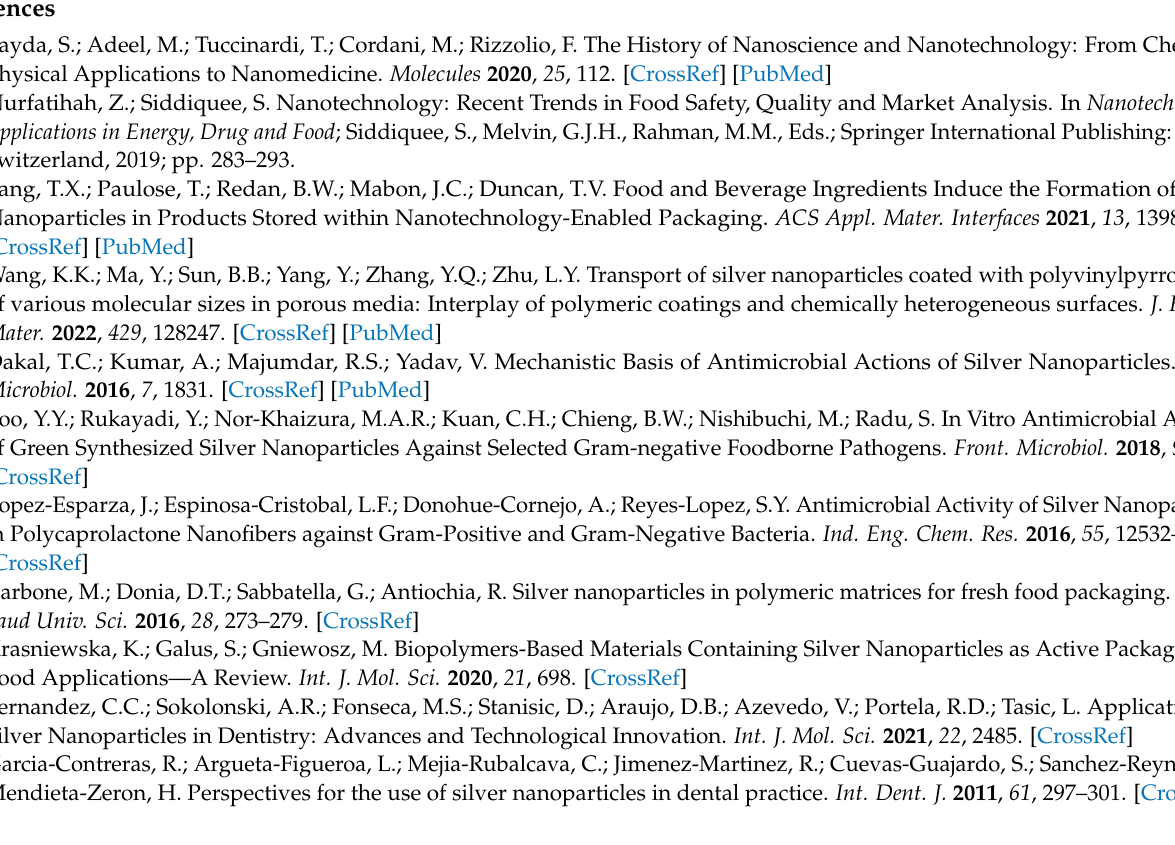
Figure S3: ROS intracellular accumulation of non-digested Ag NMs treated conditions; Figure S4: Double strand break level was measured via 53BP1 immunostaining and foci count, using high content analysis; Figure S5: Comet assay representative images; Table S1: Composition of simulated OGI fluids; Table S2: Sequences of qPCR primers; Table S3: Size distribution and zeta potentials of non-digested and digested Ag NPs in filtered fluids. References [22,27] are cited in the supplemen- tary